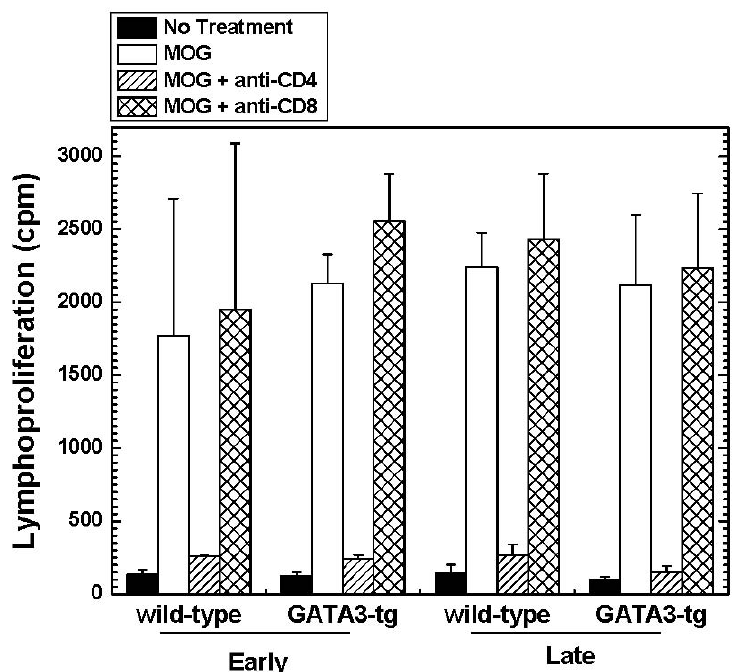
Figure 5. Lymphoproliferative responses of wild-type and GATA3-tg mice with EAE two weeks (early) and two months (late) p.i. MNCs were cultured with MOG presence or absence of anti-CD4 (hatched bars) or anti-CD8 (cross-hatched bars) antibody. Both groups of mice showed substantial MOG-specific proliferation with no significant differences between the groups. In both groups, anti-CD4 antibody incubation significantly reduced MOG-specific lymphoproliferation, whereas anti-CD8 antibody incubation had no effect. Lymph nodes were pooled from two to three mice. Values are mean + SEM of two to three pools of lymph node cells and are representative of one experiment (early) and four experiments (late) with similar results.